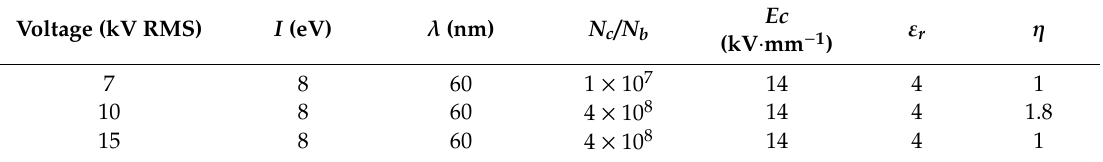
Table 2. Parameters of media used for simulating the case study, taken from